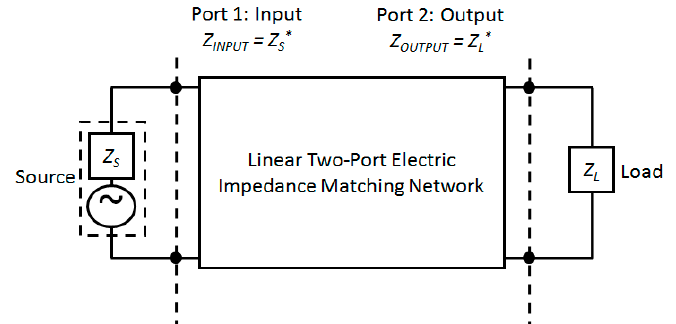
Figure 1. Block diagram of a two-port network for electric impedance matching showing the complex conjugate matching of source and load impedance with the two ports.